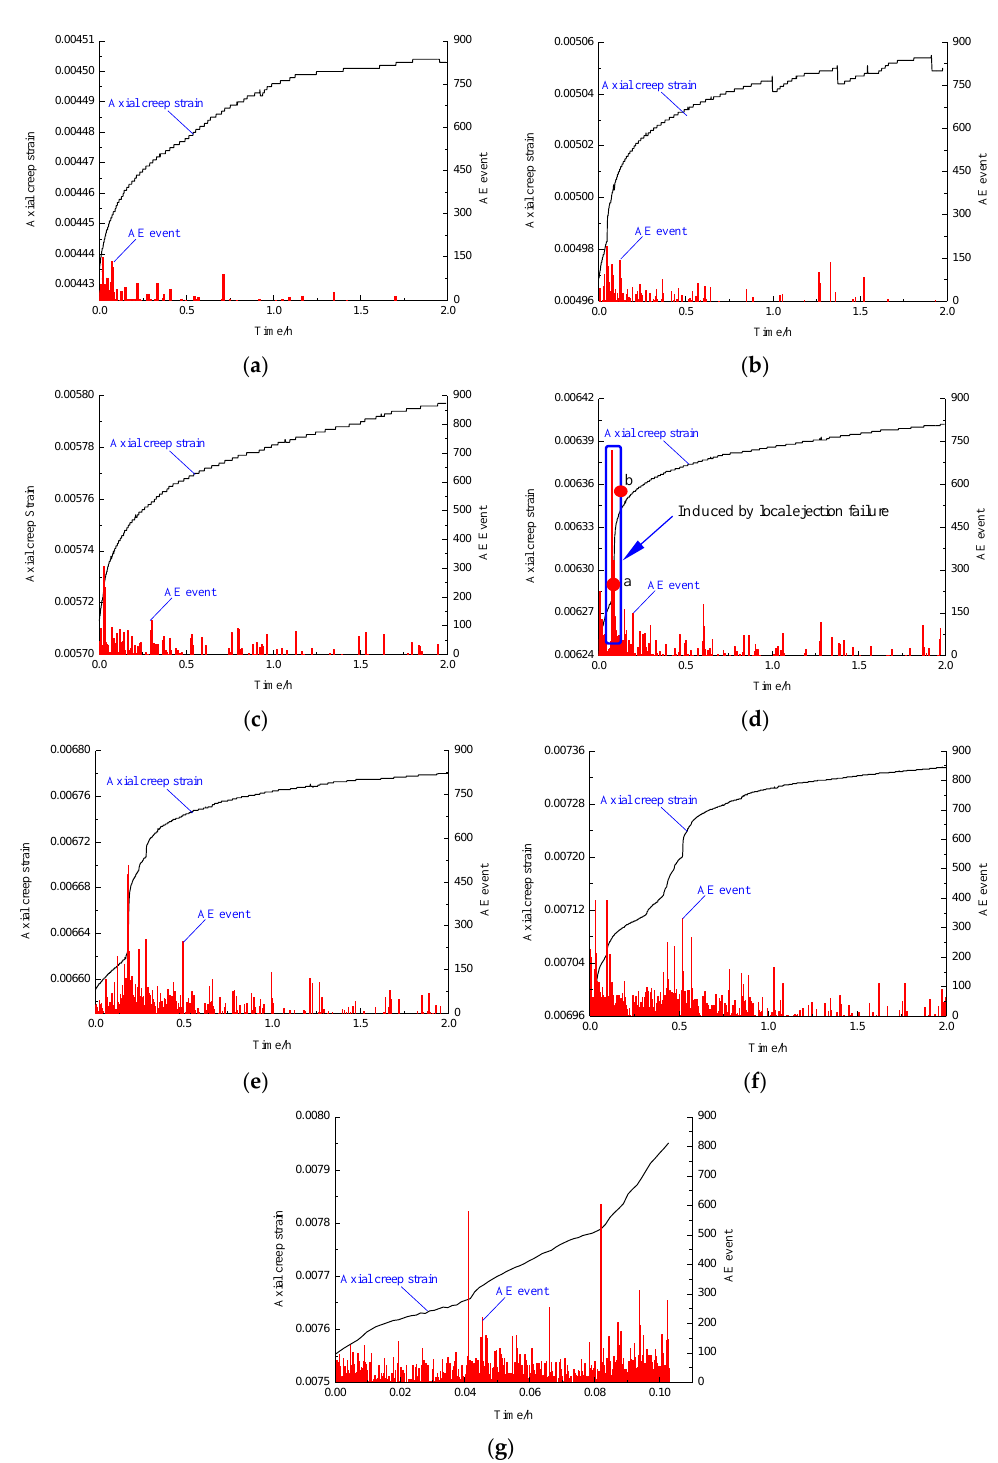
Figure 13. AE event variety curves of A-1 composite samples at creep stage for different stress levels: ( a ) AE event variety curve at the stress level of 7.07 MPa; ( b ) AE event variety curve at the stress level of 8.48 MPa; ( c ) AE event variety curve at the stress level of 9.90 MPa; ( d ) AE event variety curve at the stress level of 11.31 MPa; ( e ) AE event variety curve at the stress level of 12.02 MPa; ( f ) AE event variety curve at the stress level of 12.73 MPa; ( g ) AE event variety curve at the stress level of 13.44 MPa.